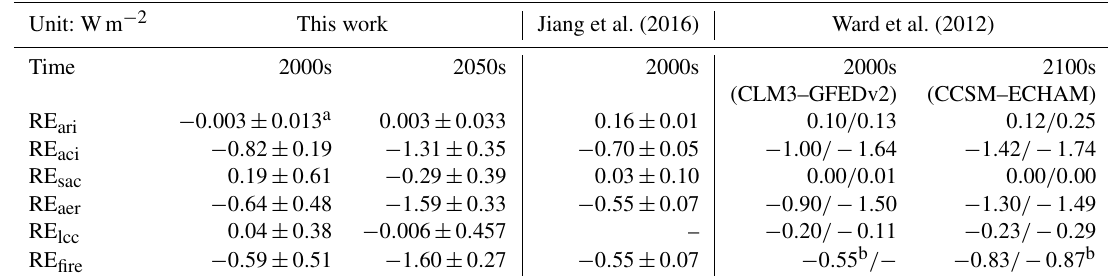
Figure 3. Present-day simulation of fire-contributed annual average radiative effects through (a) aerosol–radiation interactions (RE ari , Wm − 2 ), (b) aerosol–cloud interactions (RE aci , Wm − 2 ), (c) fire-aerosol-induced surface albedo change (RE sac , Wm − 2 ), and (d) fire- aerosol-related net radiative effects (RE aer , Wm − 2 ). All these radiative effects are estimated as changes in the shortwave radiative flux at the TOA between the CTRL1 and SENS1A experiments. The hatching denotes the 0.05 significance level. Table 2. Comparison of fire-related radiative effects in the present-day (CTRL1–SENS1A) and RCP4.5 future (CTRL2–SENS2A) scenarios based on this work and previous